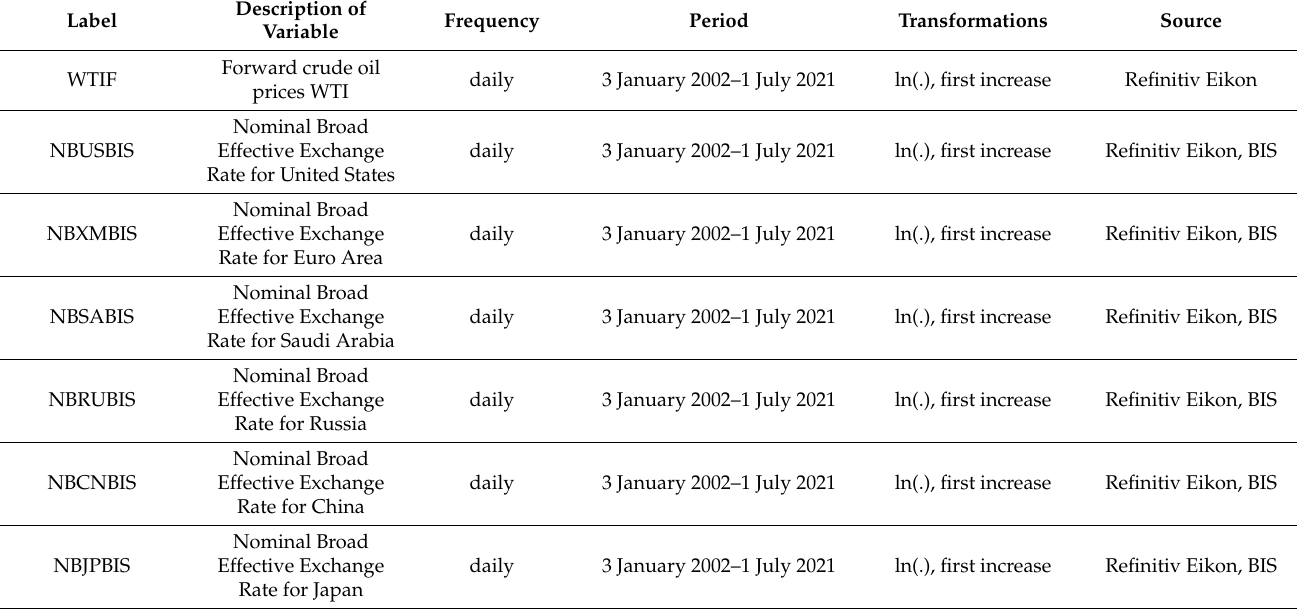
Table 1. Variables used in the study.